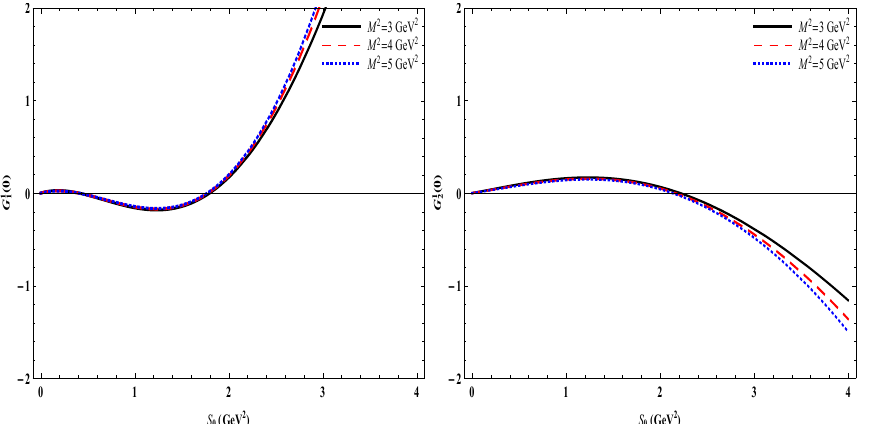
( 0 ) and G 1 ( 0 ) on continuum threshold S 2 1